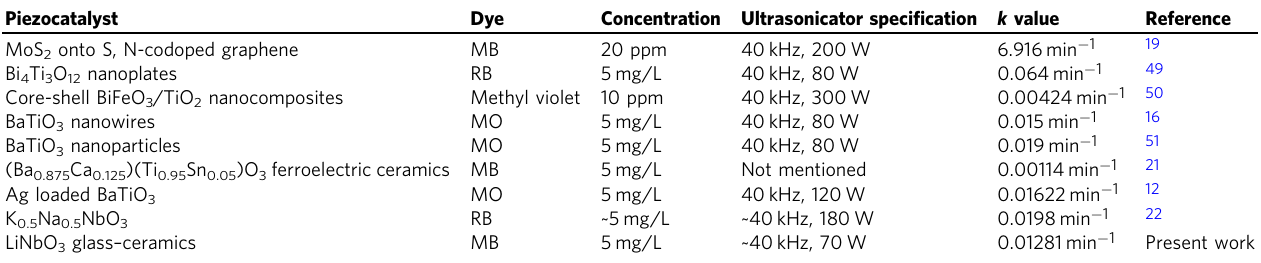
Table 2 Comparative piezocatalytic performance of present glass – ceramic with reported piezocatalysts.